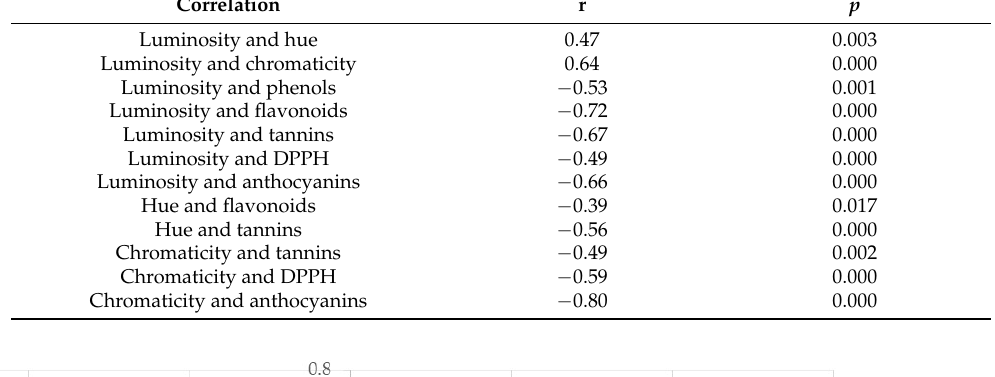
Table 4. Correlation analysis, of bean color and nutraceutical compounds with a confidence level of 95%.